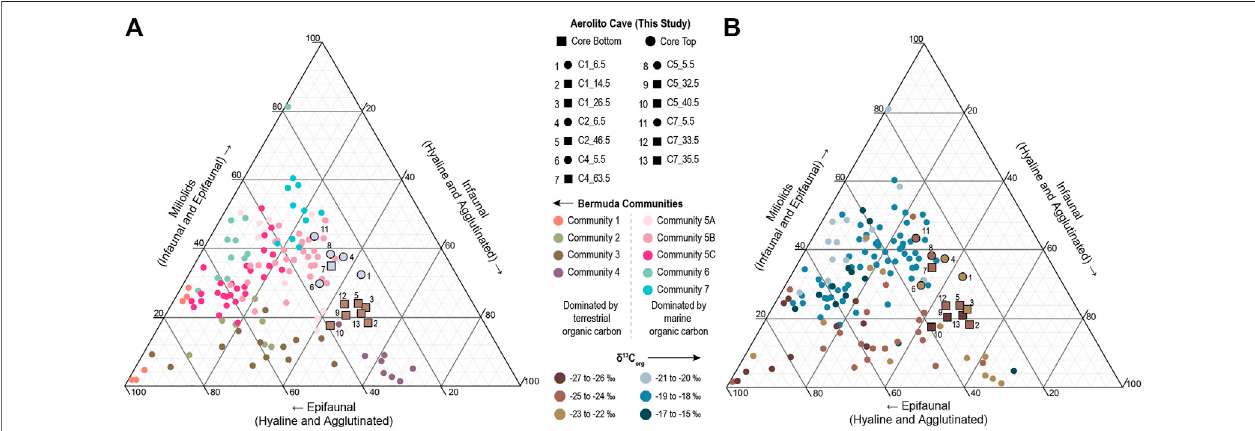
FIGURE 7 | Ternary diagrams depicting the proportion of benthic foraminiferal taxa in each sample organized into miliolid, non-miliolid epifaunal, and non-miliolid infaunaltaxa.Resultsfromthisstudy(numberedcirclesandsquares)arecomparedtobenthicforaminiferafromkarstsubterraneanestuariesinBermuda(smallercircles) (CresswellandvanHengstum,2021).Samplesintheternarydiagramarecolorcoded (A) bycommunitydesignation(AerolitoCaveOM-limitedCommunityinpurpleand OM-enriched Community in brown), and (B) by δ 13 C org values of sediment